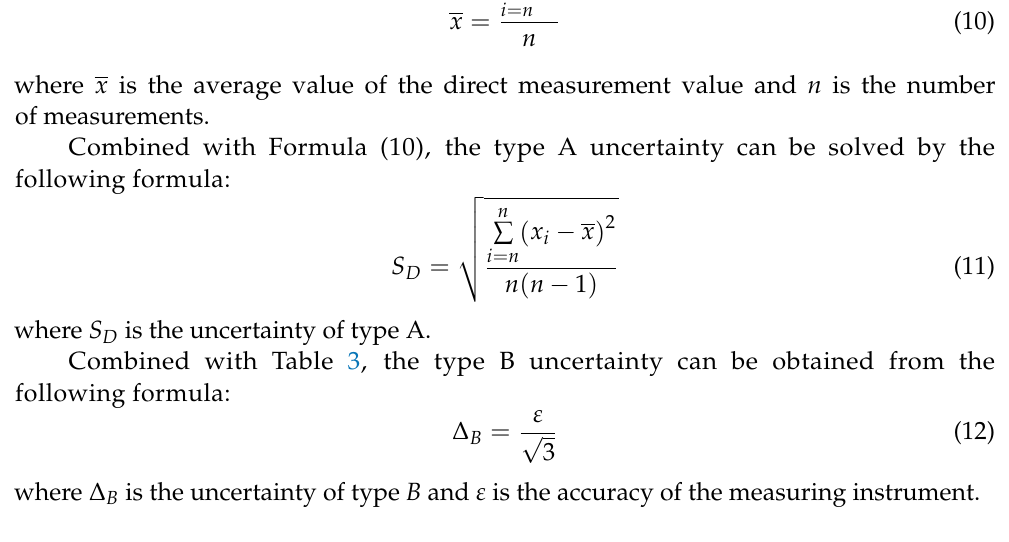
Table 3. Application range and accuracy of measuring